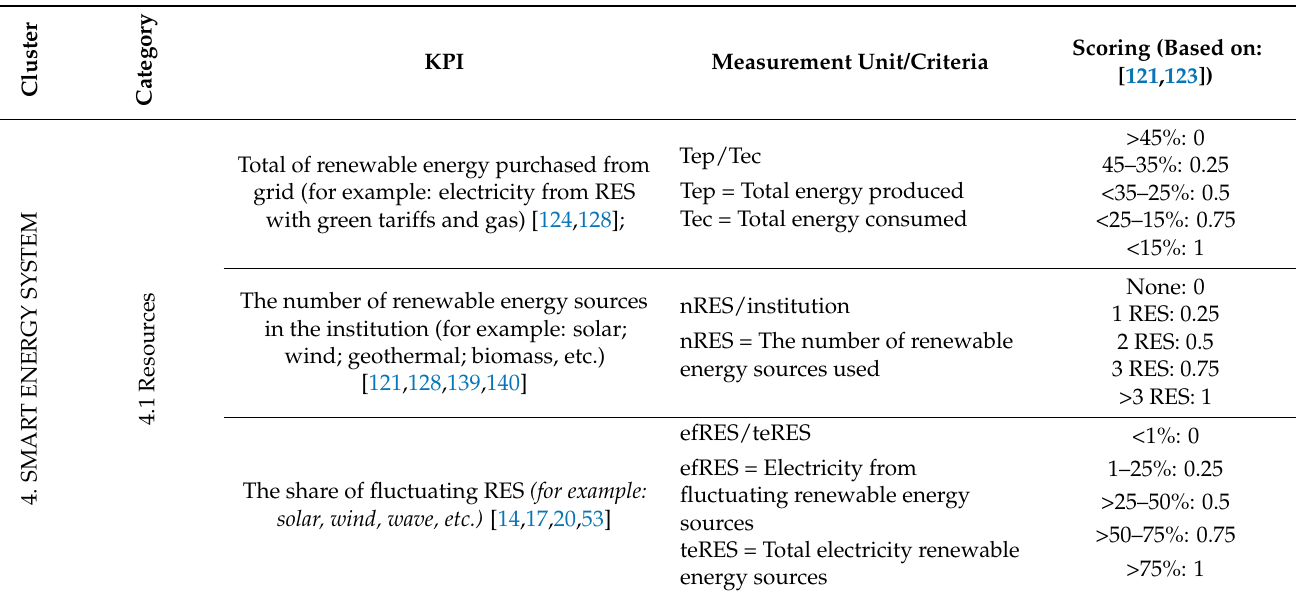
Table 4. KPIs for the SESs’